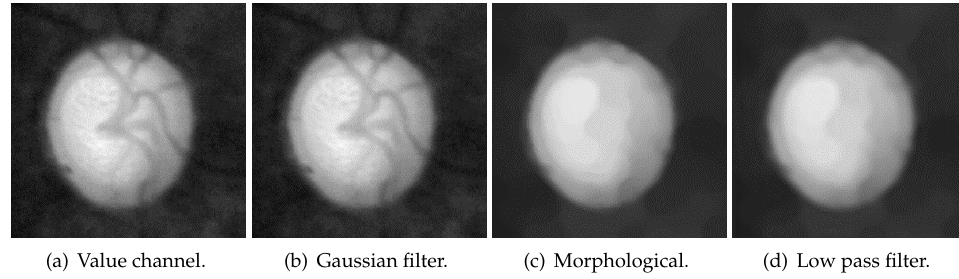
Figure 13. The result of each process in blood-vessel and noise